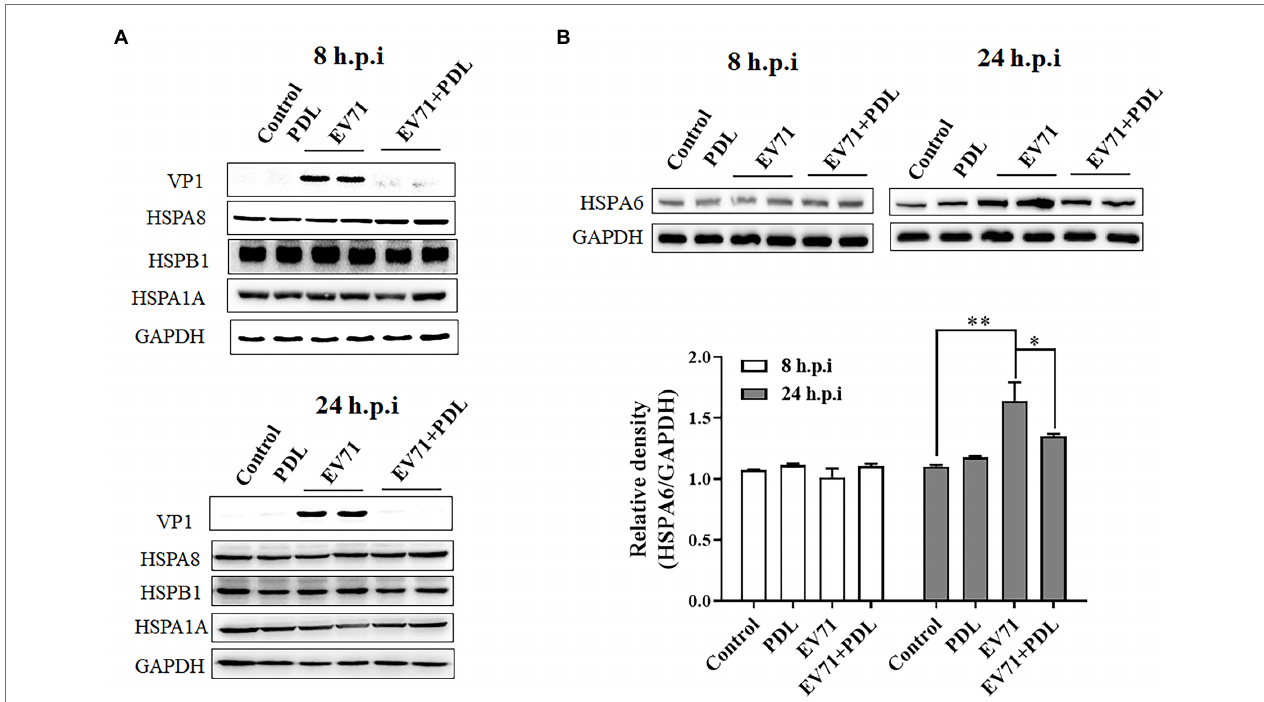
FIGURE 2 | EV71 infection specially upregulates HSPA6 protein expression. (A) Western blotting analysis of HSPA1A, HSPA8, HSPB1, and viral VP1 expression in RD cells infected with EV71 for 8 or 24 h. (B) Western blotting analysis of HSPA6 expression in RD cells infected with EV71 for 8 or 24 h. The relative expression